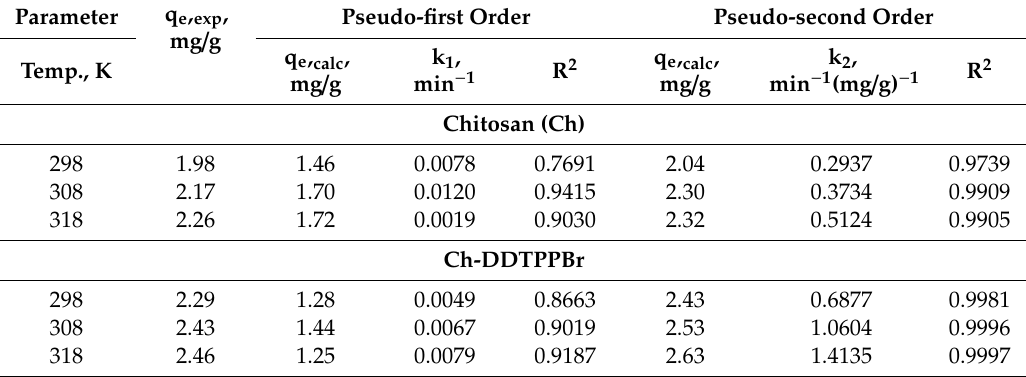
Figure 7. Pseudo second-order kinetic model ( a ) Ch; ( b ) Ch-DDTPPBr. Table 1. Kinetic parameters for adsorption of Ag (I) on the adsorbent materials.